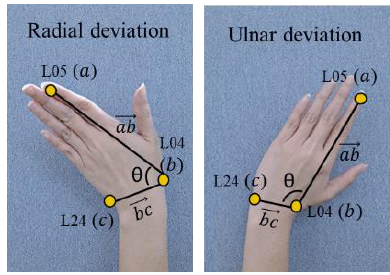
Figure 6. Wrist bending position (radial – ulnar deviation).